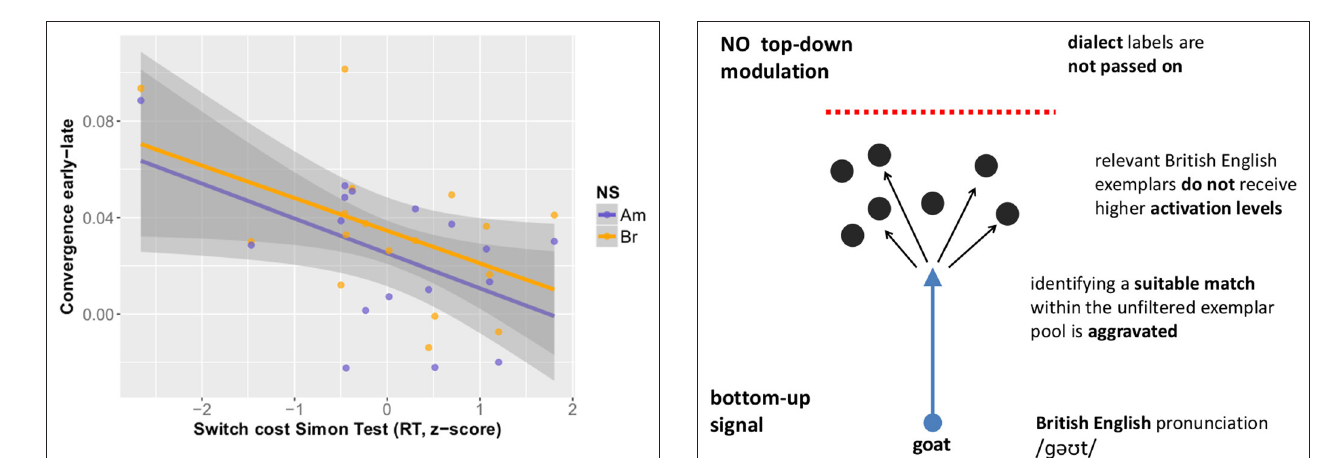
FIGURE 6 | Match finding in the absence of top-down modulation as a consequence of poorly indexed exemplars. Modified from Lewandowski (2012) , employing an ART framework (Grossberg,